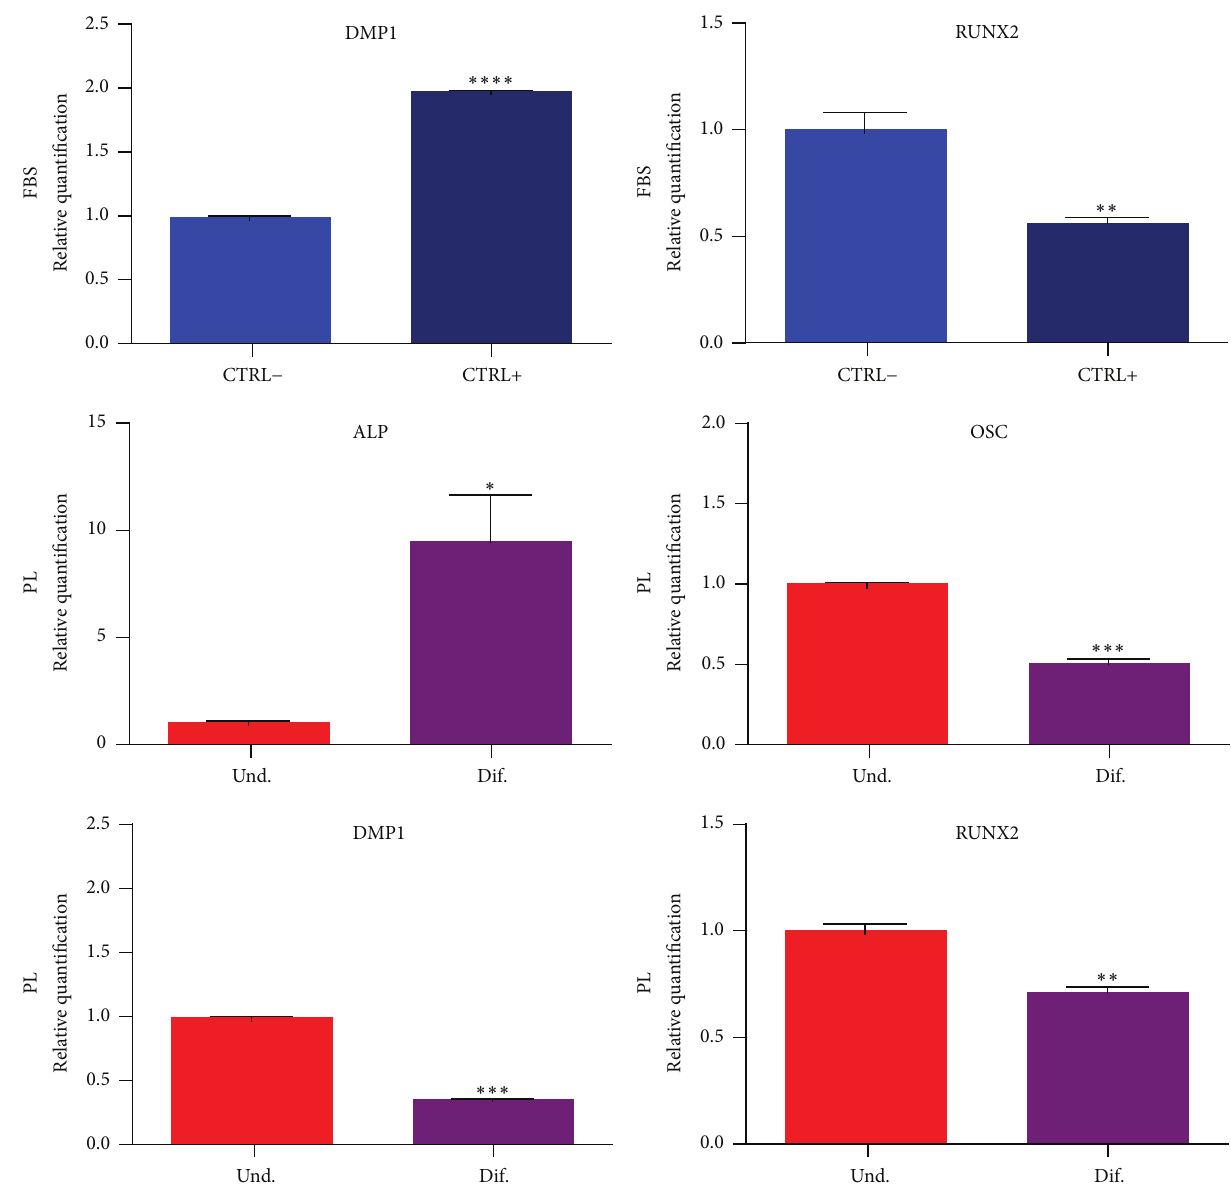
Figure 6: Effect of PL on osteogenic differentiation of DPSCs. Alizarin red staining on undifferentiated sample cultured in growth medium with 10% FBS (a) or 1% PL (d) and on samples differentiated with osteogenic medium containing 20% FBS (b) or 1% PL (e). Relative quantification of the same staining by spectrophotometry. Data shown as mean + SD, 𝑛 = 3 samples. Two different experiments were performed. Significant levels according to unpaired 𝑡 -test ( ∗ 𝑃 < 0.05 ; ∗∗ 𝑃 < 0.01 ; ∗∗∗ 𝑃 < 0.001 ; ∗∗∗∗ 𝑃 < 0.0001 ). (g) Relative quantification of osteogenic markers by real-time PCR on samples derived from the end (28 days) of the differentiating protocol. Data shown as mean + SD, 𝑛 = 3 . Significant levels according to unpaired 𝑡 -test ( ∗ 𝑃 < 0.05 ; ∗∗ 𝑃 < 0.01 ; ∗∗∗ 𝑃 < 0.001 ; ∗∗∗∗ 𝑃 < 0.0001